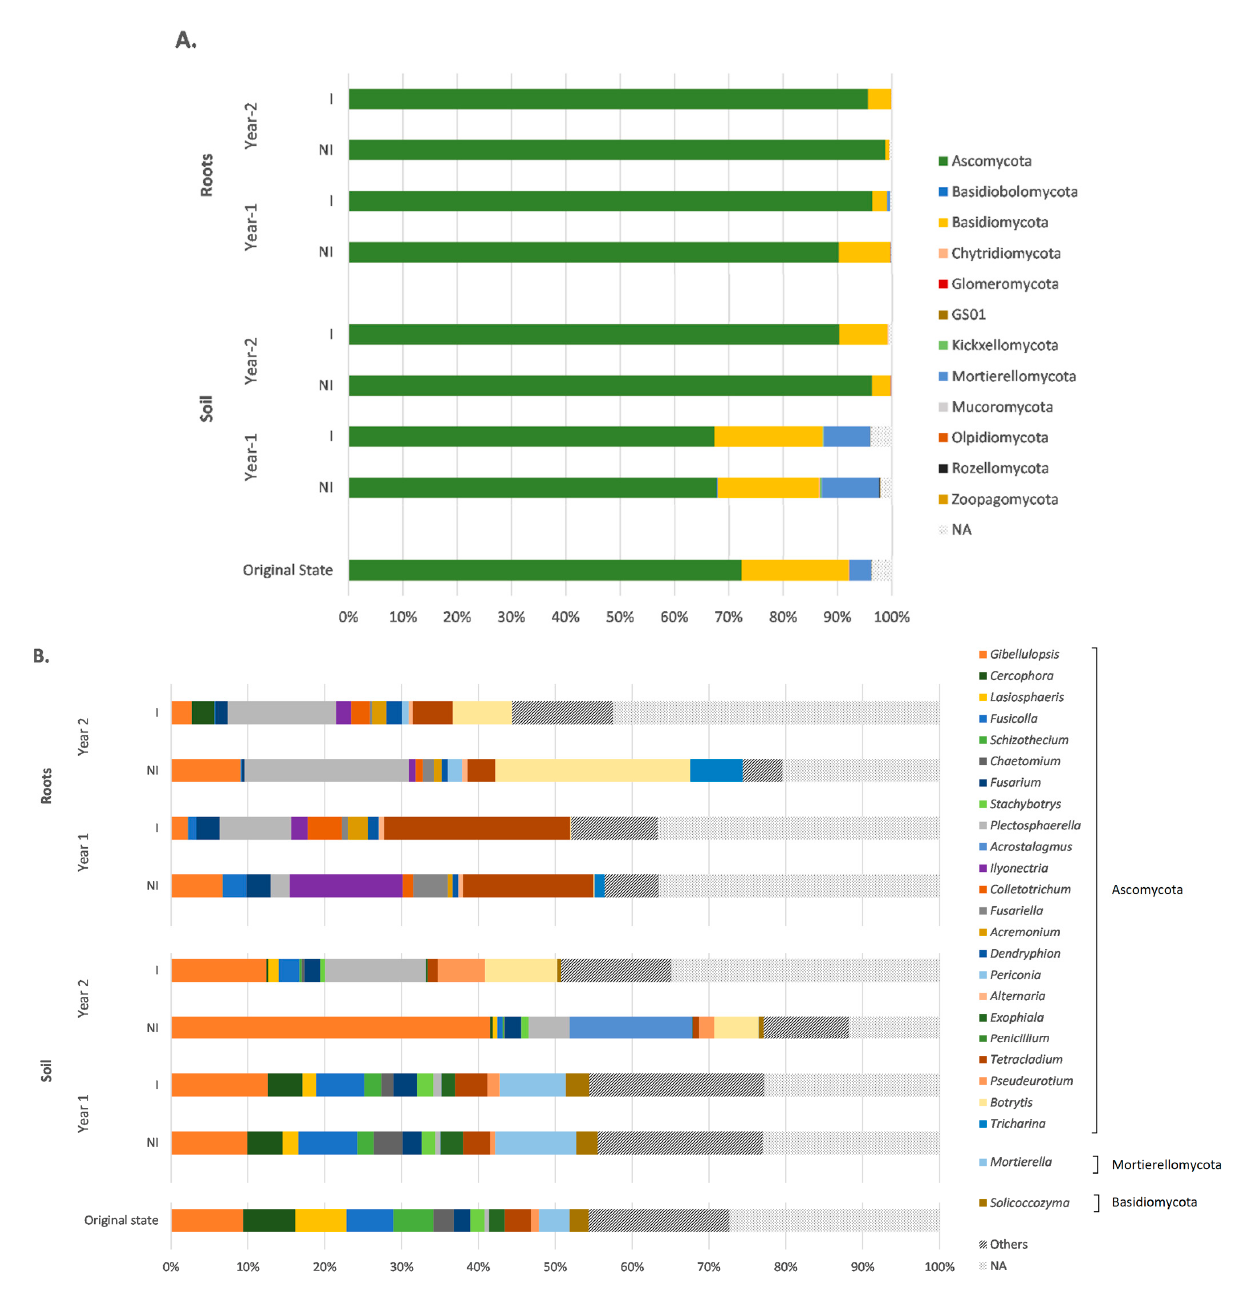
Figure 3. Relative abundances of major phyla ( A ) and genera ( B ) of the fungal ITS rRNA gene data set, according to the different experimental conditions for both root and soil biotopes. The genera were grouped by phylum, and those with a relative abundance lower than 0.5% were gathered in the “Others” group. NI: non-inoculated; I: inoculated; NA: non- assigned.